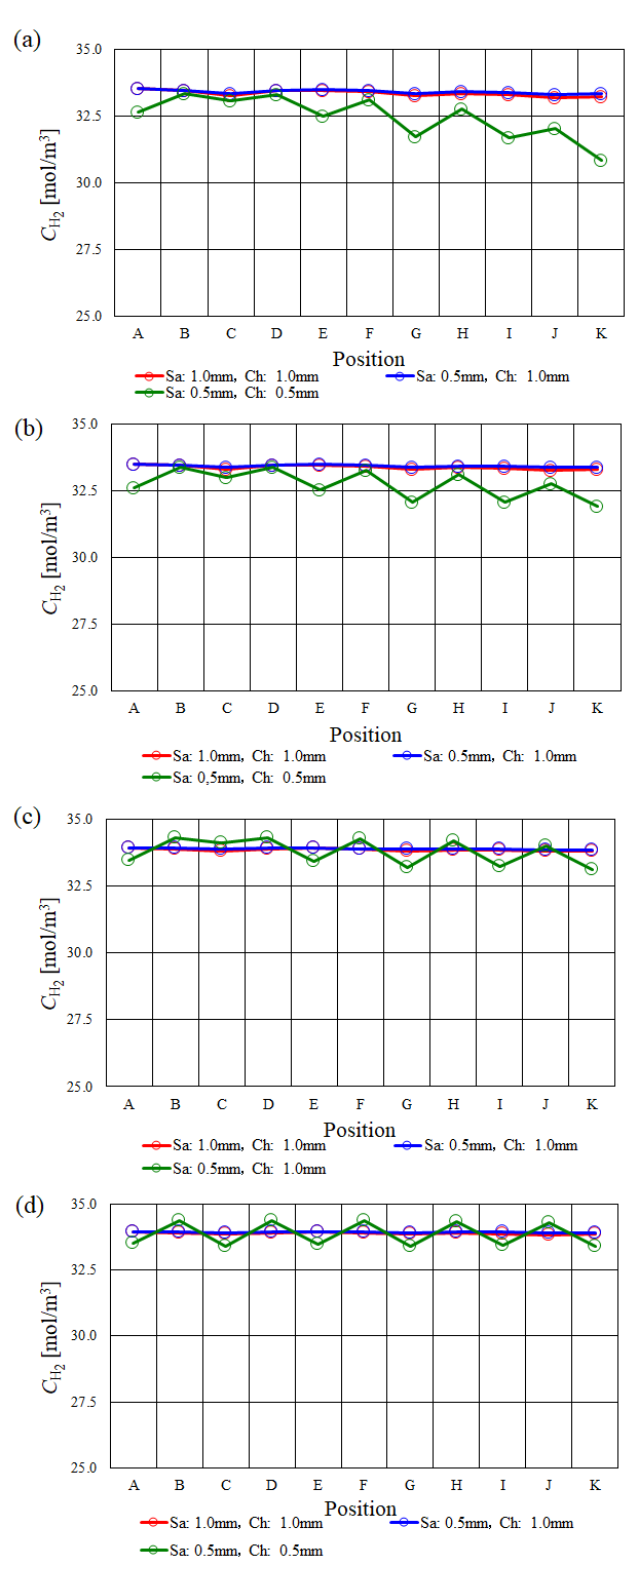
Figure 2. Molar concentration of H 2 along with the gas channel on the interface between PEM and catalyst layer at the anode among various s.t. at T ini = 353 K. ( a ) A80%RH/C80%RH, ( b )